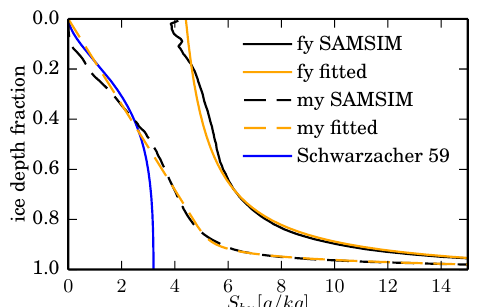
Figure 14. Yearly mean first-year (fy) and multiyear (my) sea-ice salinity profiles of SAMSIM using the complex parametrization. The fitted analytical functions of the profiles listed in Sect. 4.4 are added in orange. Although the profile of Schwarzacher (1959) is summer biased (see Sect. 4.3.3), we have included it as a reference.